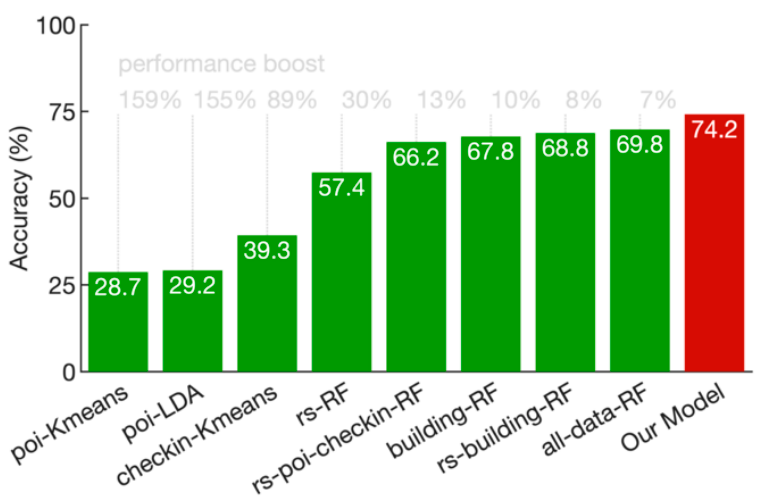
Figure 8. Classification accuracy of XGBoost and RF on different feature sets.